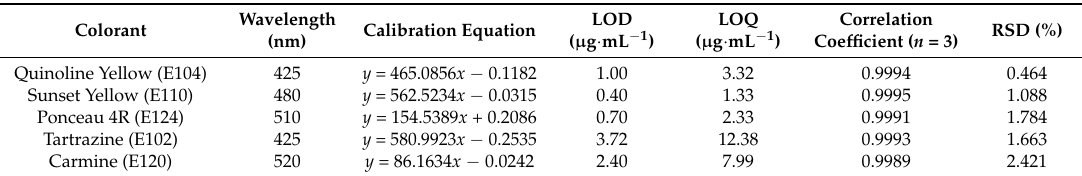
Table 2. Chromatographic characteristics of the method for the high performance liquid chromatography (HPLC) analysis of